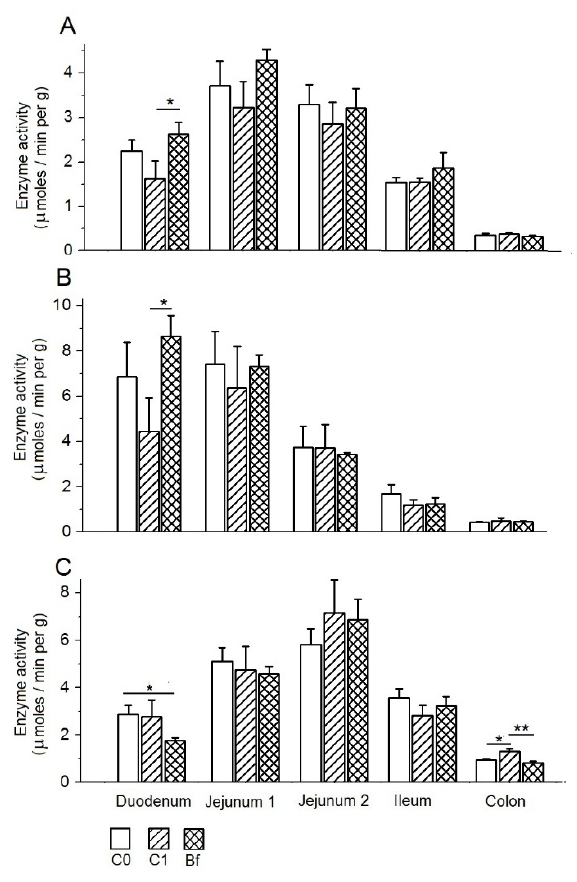
Figure 7. Effects of indigenous bifidobacteria on the specific activities of maltase ( A ), alkaline phosphatase ( B ), and aminopeptidase N ( C ) in the mucosa of different parts of the intestine in a rat model of antibiotic-associated dysbiosis. ( A – C ) The rat groups: C0 (control)—without the introduction of antibiotics and autoprobiotics, C1—without the introduction of autoprobiotics after the withdrawal of antibiotics, and Bf—with the introduction of indigenous bifidobacteria after the withdrawal of antibiotics. ( A , B ) Student’s t -test, * p < 0.05. ( C ) Student’s t -test. * p < 0.02, ** p < 0.01.